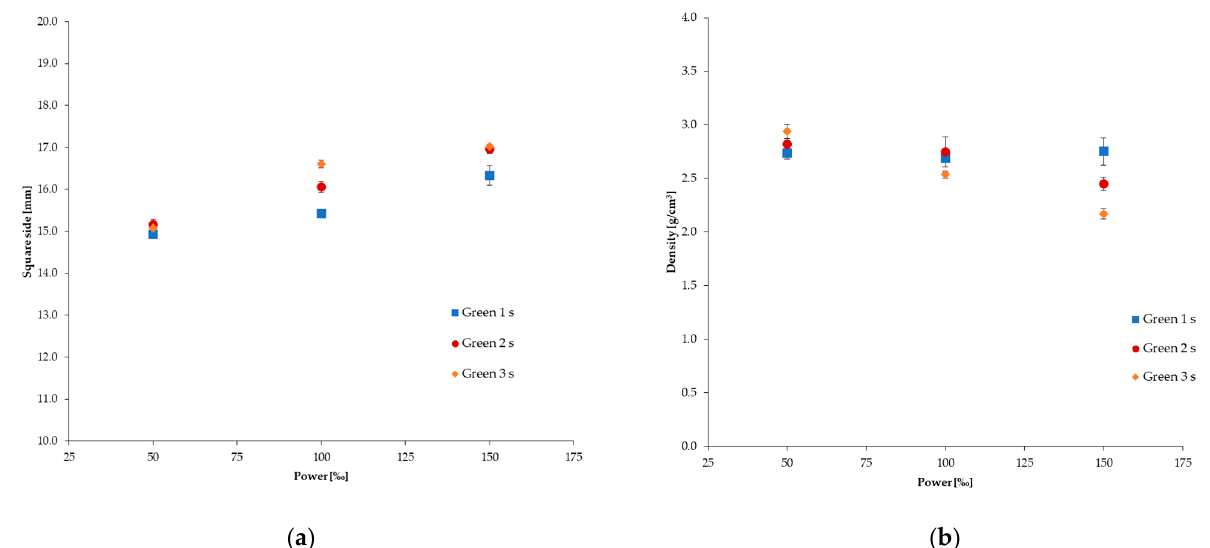
Figure 9. Diameter dimension ( a ) and measured density ( b ) of the DLPed discs with 25 µm layer thickness.